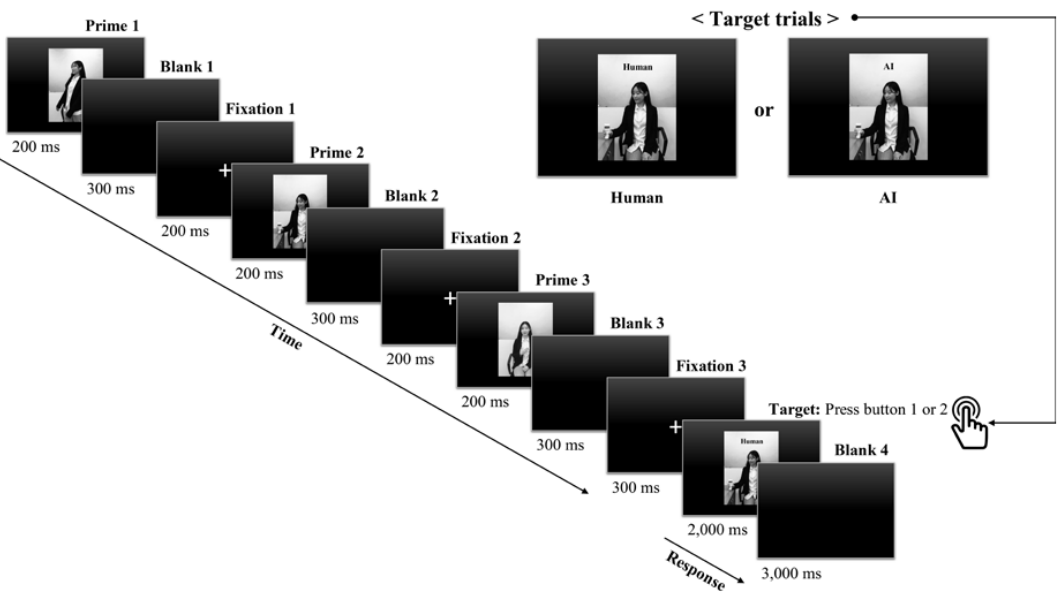
Figure2. Event-relatedpotential(ERP)experimentalparadigmpresentedduringtheelectroencephalogram (EEG)